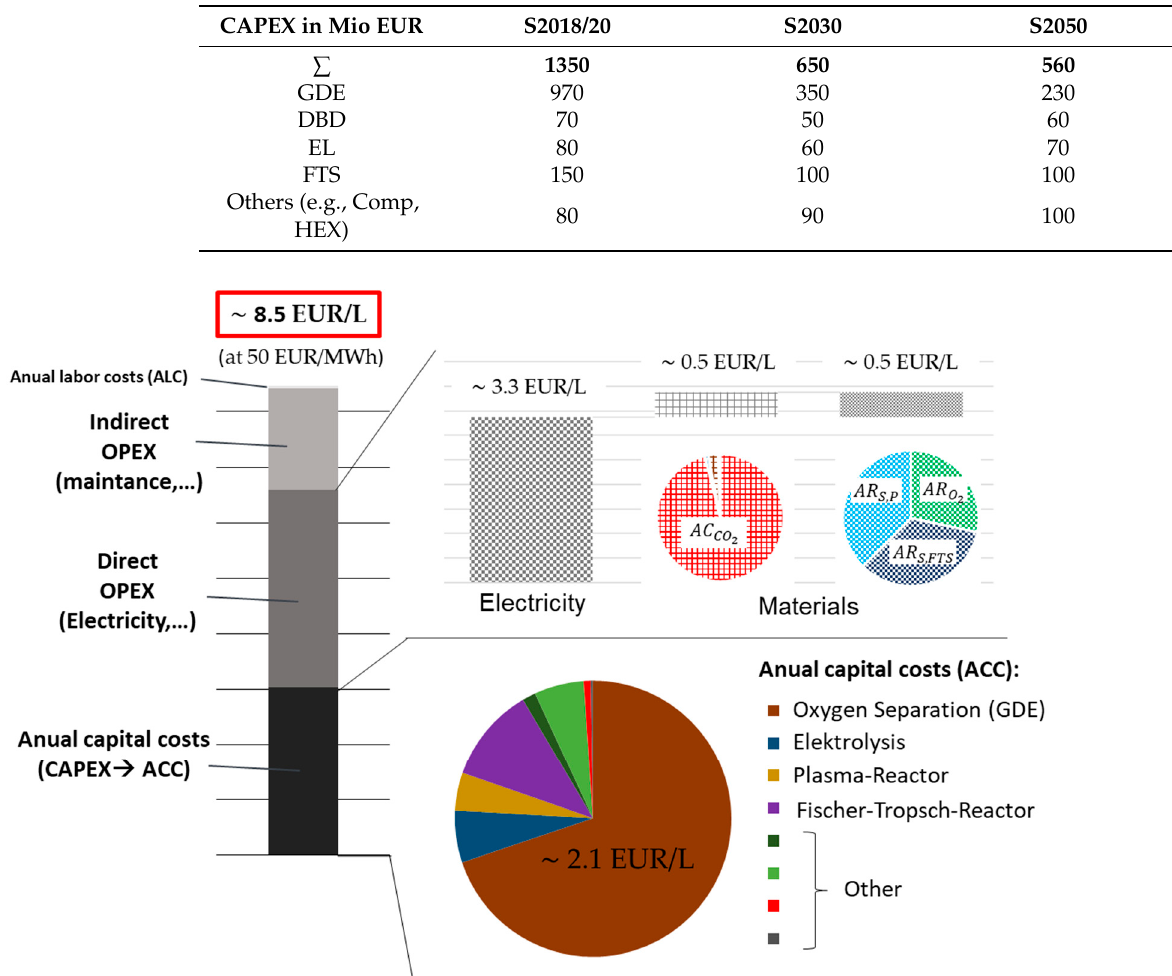
Table 8. CAPEX of the different scenarios S2018/20, S2030, and S2050 (DBD-Plant) consisting of investments for the gas diffusion electrode (GDE), dielectric barrier discharge plasma reactor (DBD), electrolysis system (EL), Fischer–Tropsch synthesis reactor (FTS), and other components, e.g., compressors (Comp) and heat exchangers (HEX).